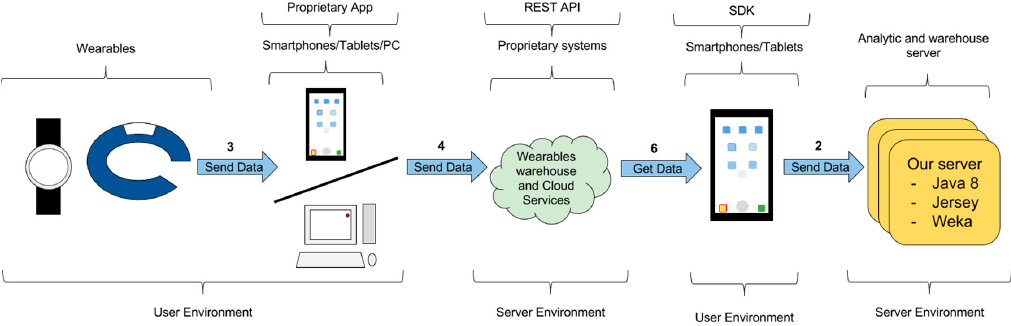
Figure 7. System representation for the warehouse data transfer—indirect access.